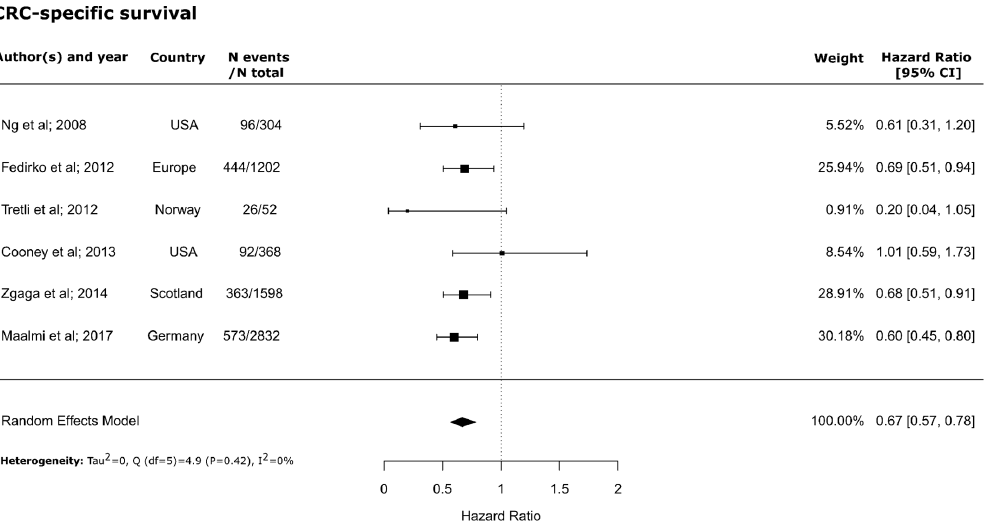
Figure 3. Forest plot for the association of high versus low 25-hydroxyvitamin D 3 (25(OH)D) levels with CRC-specific survival in patients with colorectal cancer. CI: Confidence interval.